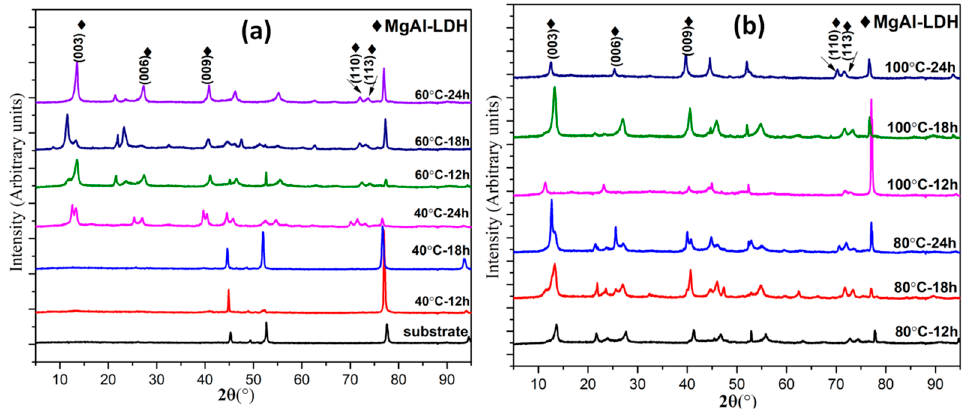
Figure 2. The XRD spectra of Mg-Al layered double hydroxide (LDH) film samples developed on aluminum alloy AA6082 obtained at various reaction temperature and crystallization times.